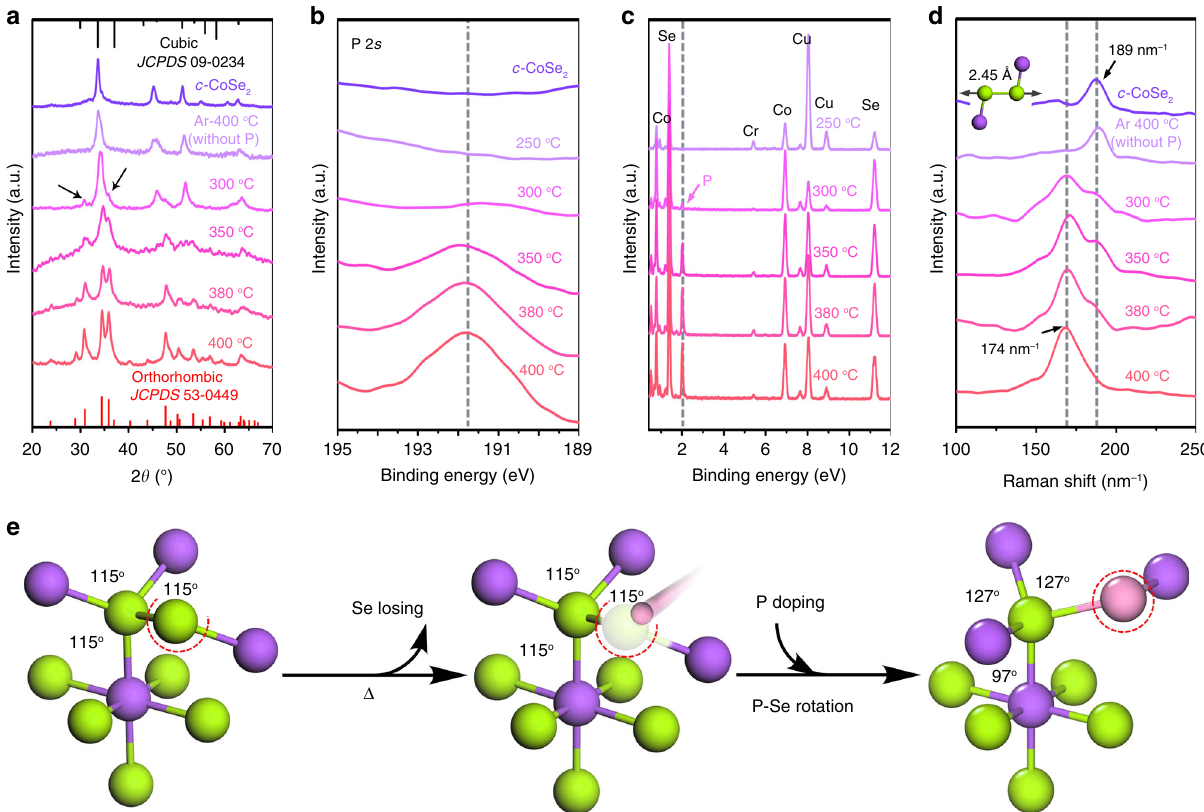
Fig. 2 P-doping-assisted structural phase transition. a – d Temperature-dependent XRD patterns, P 2 s XPS spectra, EDX spectra, and Raman spectra reveal the structural phase change from c -CoSe 2 to o -CoSe 2 |P, respectively. e Schematic of the P-doping-assisted phase-transition process from cubic